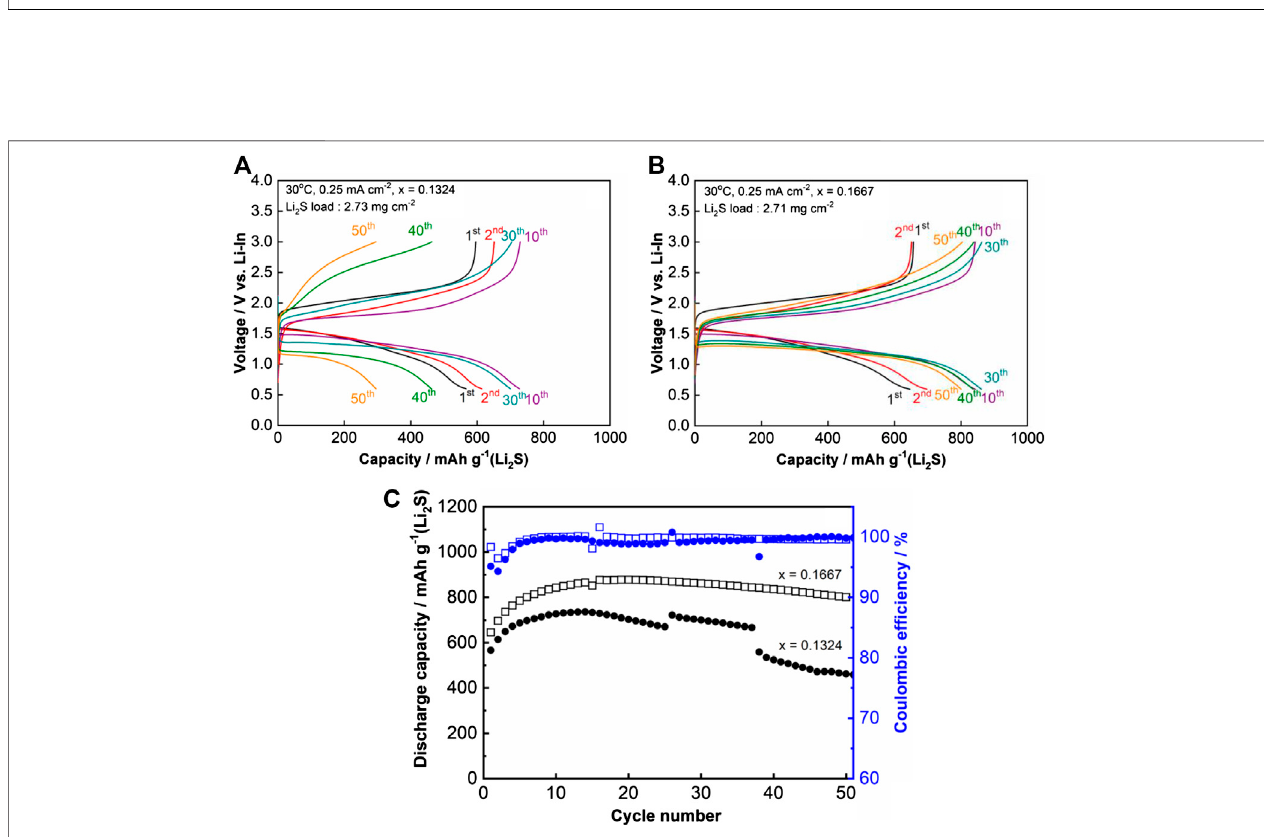
FIGURE 3 | Charge-discharge curves of the all-solid-state cells employing Li (Al